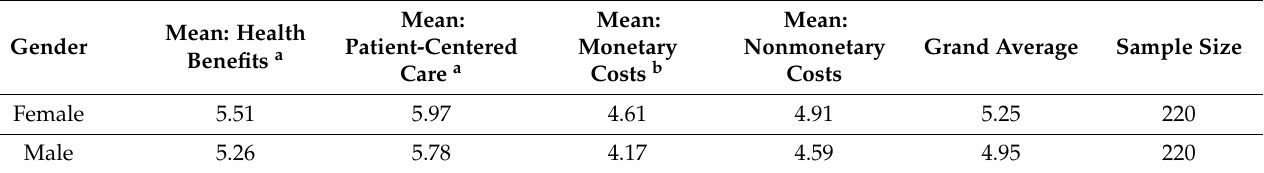
Table 4. Means for Dimensions of Patient Satisfaction by Patient